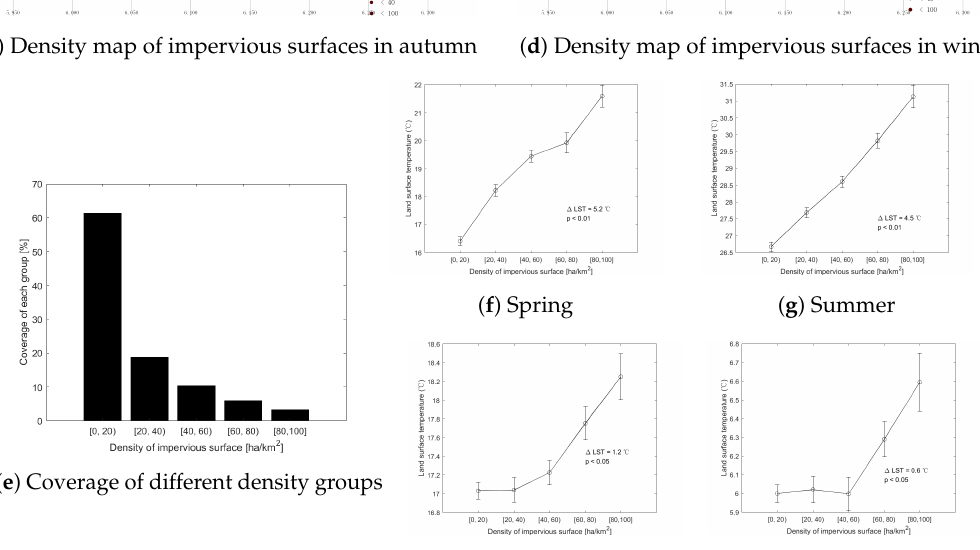
Figure 12. Density map of impervious surfaces for four seasons in Geneva. Different colored areas and sized circles indicate various temperatures ( ◦ C) and different densities respectively. Figures ( f – i ) present the relationships between LST and density of green area with 95% confidence